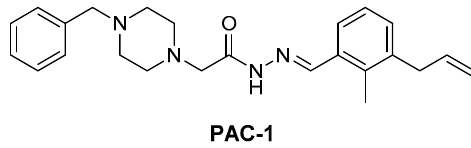
Figure 12. Procaspase activating compound 1 ( PAC-1 ).